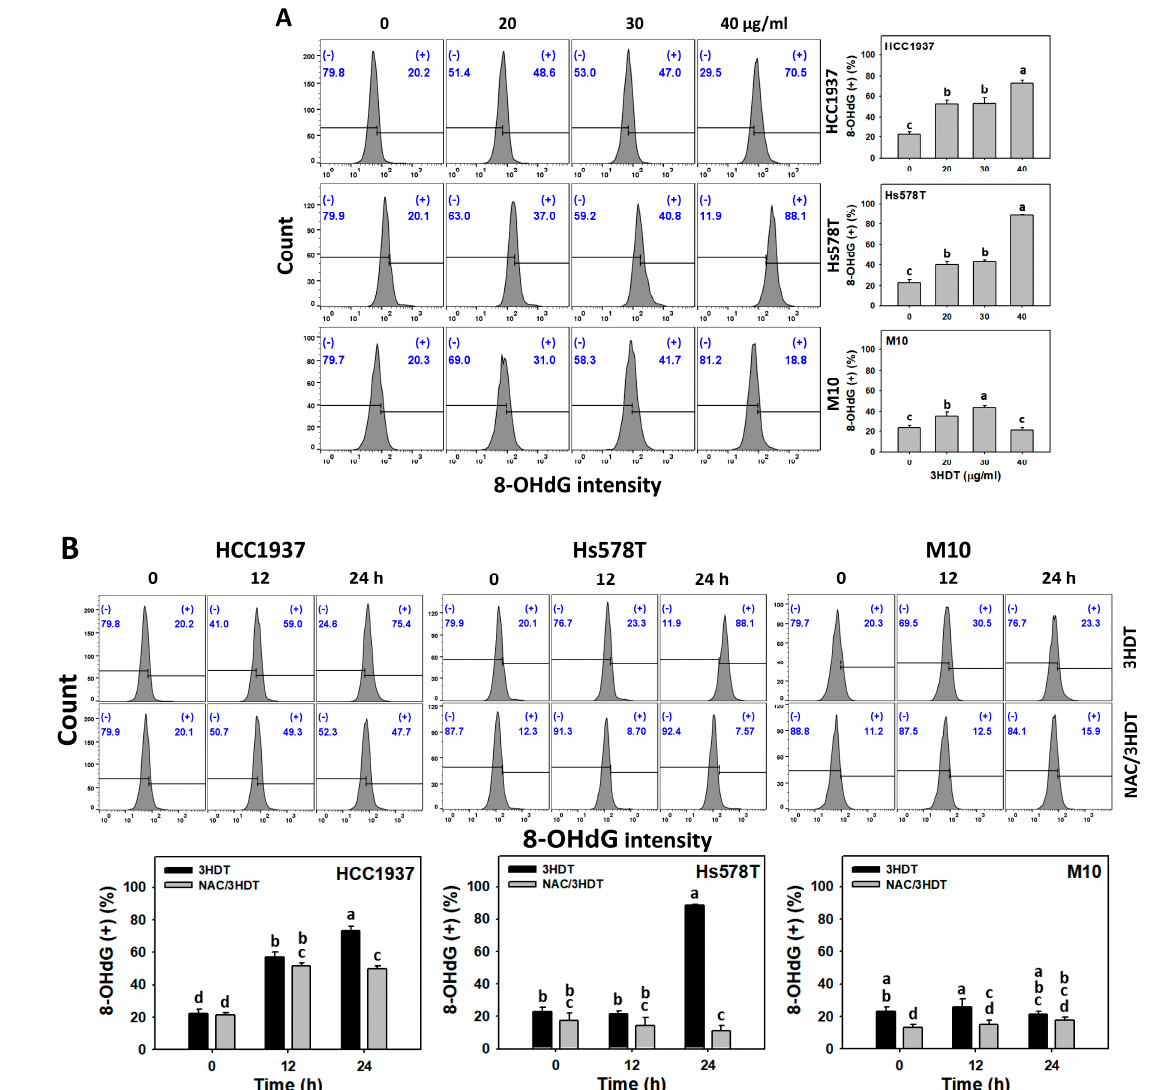
Figure 9. 8-OHdG status of 3HDT treatment. ( A ) 8-OHdG flow cytometry assay of 3HDT for 24 h. ( B ) 8-OHdG flow cytometry assay of NAC/3HDT. 3HDT and NAC/3HDT indicate 12 or 24 h 3HDT treatment (40 μ g/mL) without and with NAC pretreatment, respectively. (+) is marked as 8-OHdG (+), which indicates the proportion with high 8-OHdG level, while ( − ) indicates the proportion with low 8-OHdG level. Data: mean ± SD ( n = 3). Treatments differ significantly for multiple comparisons when the letters are not overlapping ( p < 0.05).